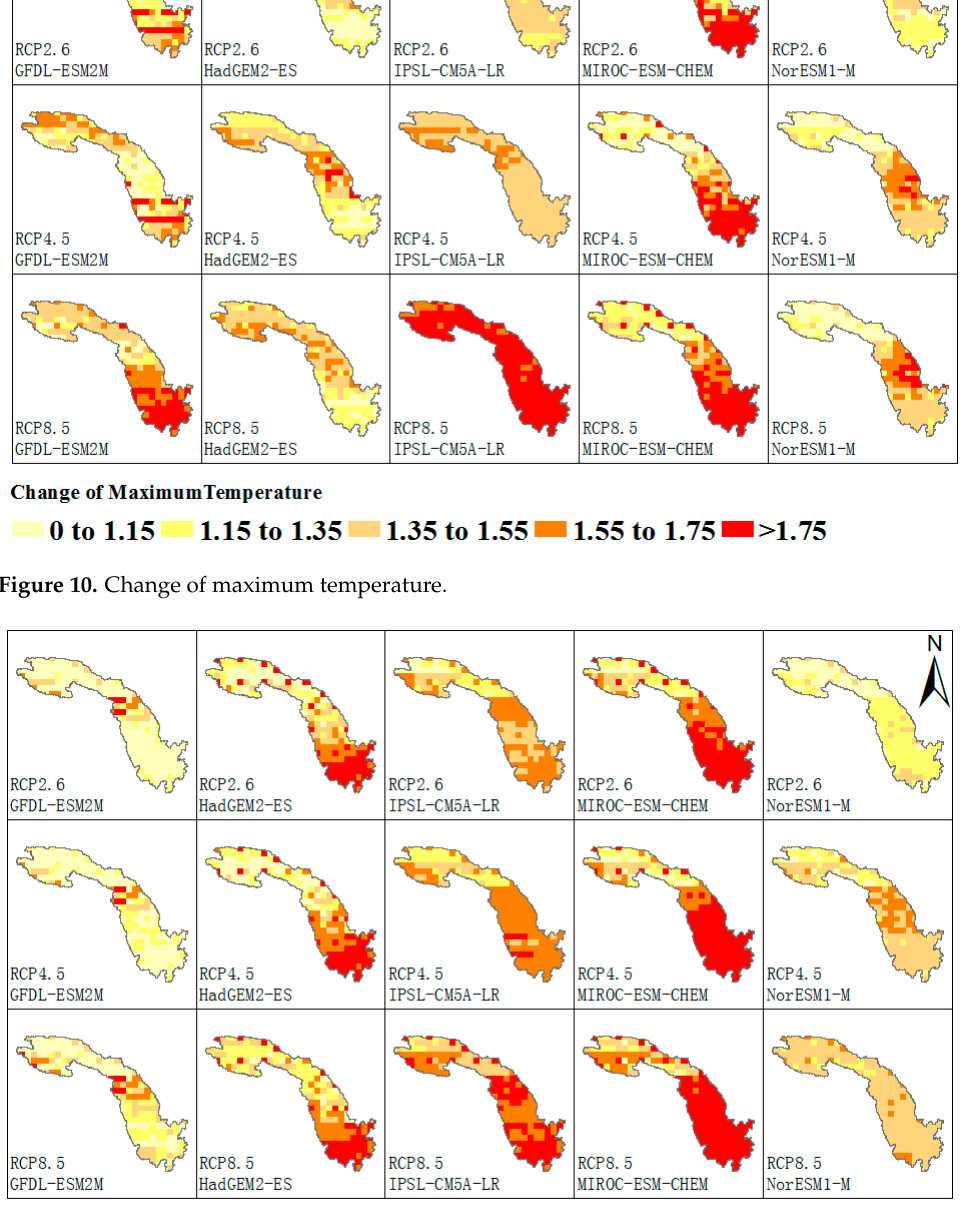
Figure 11. Change of minimum